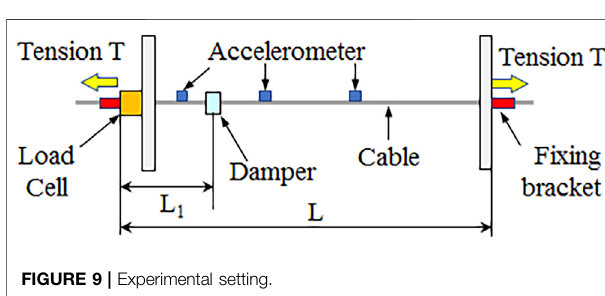
FIGURE 9 | Experimental Next, the RMSER obtained by the proposed method in the case with a damper is compared with the RMSER obtained by the higher-order vibration method in the case without a damper.